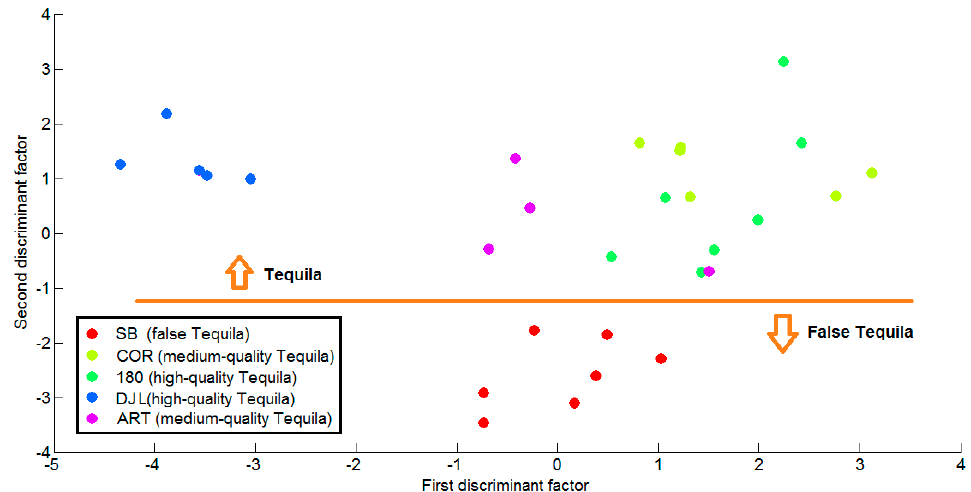
Figure 8. Cross-validation results of a linear discriminant analysis performed on the Tequila and Agave liquor (false Tequila) database. The first two discriminant factors account for about 97% of data variance. The orange line has been added to better show that the second discriminant factor is essential for correctly discriminating real Tequilas from Agave liquor.